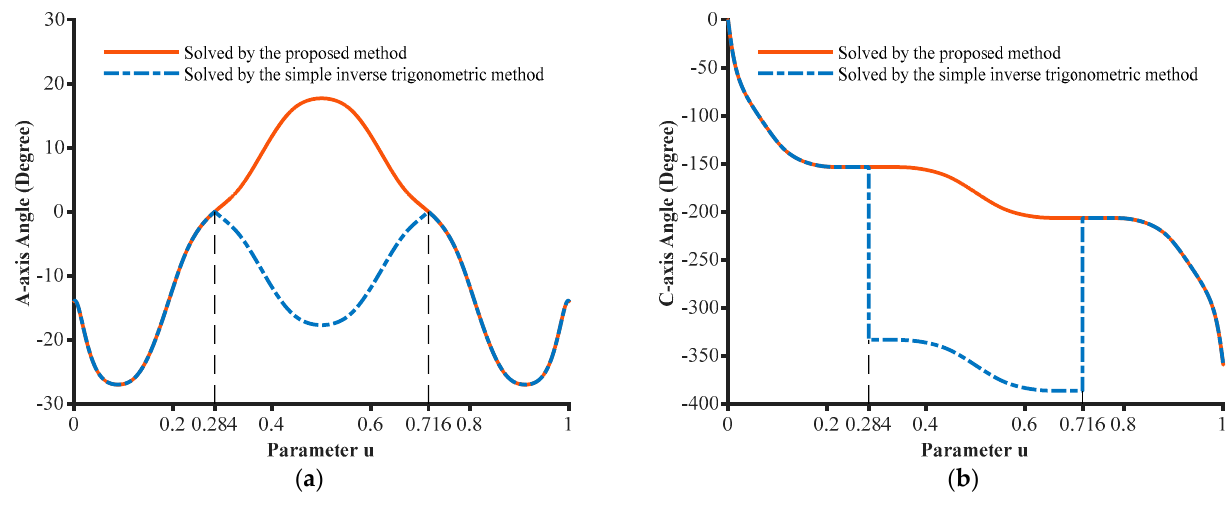
Figure 8. Solution results of rotation angles in the cardioid curve interpolation. ( a ) Results of the A − axis angle. ( b ) Results of the C − axis angle.